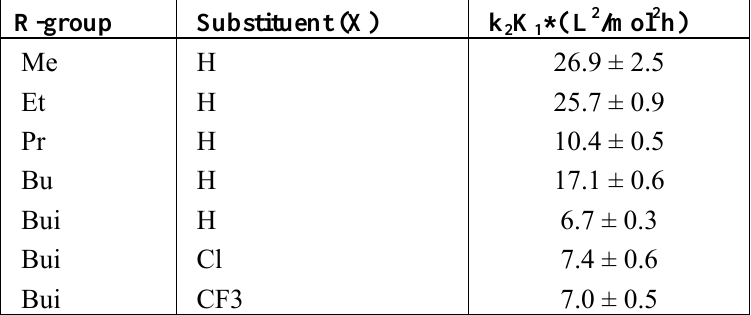
Table 8. Rate constants for the hydrolysis of para -substituted benzoate esters at 250 °C